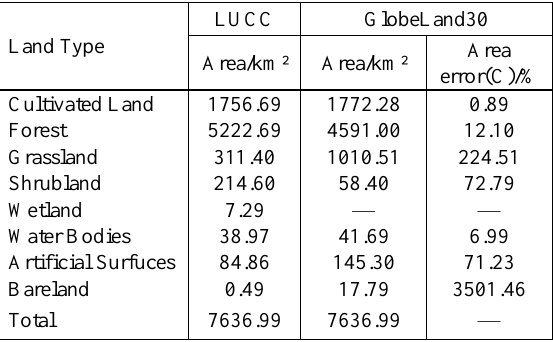
Table 3. Area statistics and error coefficient of different